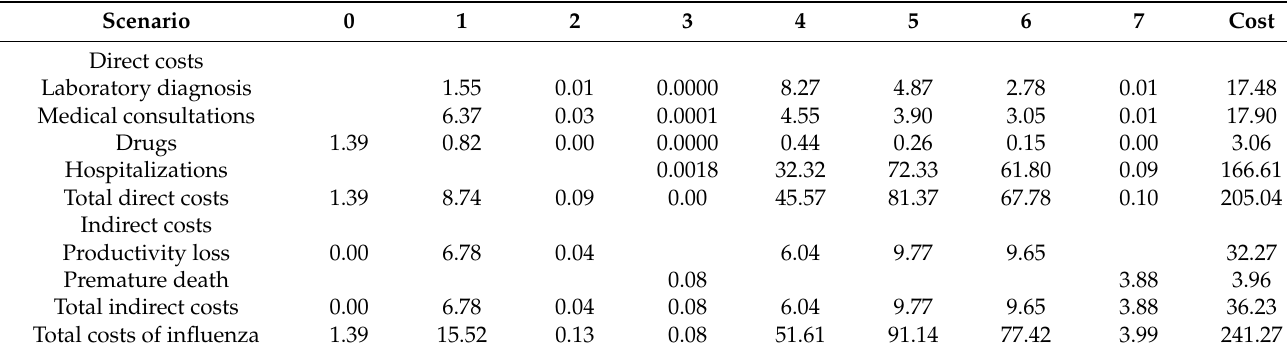
Table 7. Total economic costs of influenza treatment of target population 1 without influenza immunization (million US dollars).